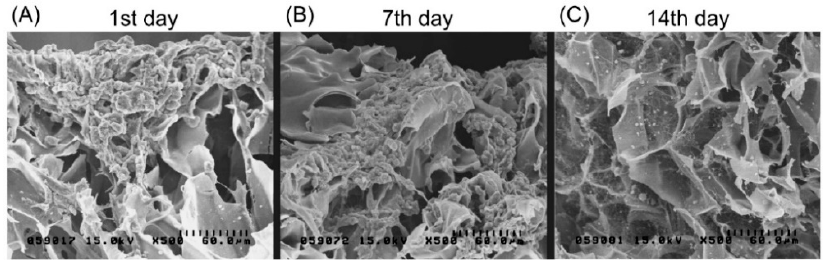
Figure 4. SEM images presenting chondrocytes (bearing magnetic nanoparticles) grown on the biphasic type II collagen–chitosan/polylactic-co-glycolic acid (CLG–CS/PLGA) scaffold at 1, 7, and 14 days after seeding. ( A ) No attachment of the cells on the scaffold after one day was observed, only their collection on the scaffold surface was indicated, ( B ) after seven days, cells started to adhere and proliferate deep into the scaffold, ( C ) after 14 days, the extracellular matrix was secreted with a higher accumulation on the scaffold surface. Cell adhesion and spreading on the pores of the scaffold is clearly visible. Magnification 500×. Adapted from [93], MDPI, 2017.